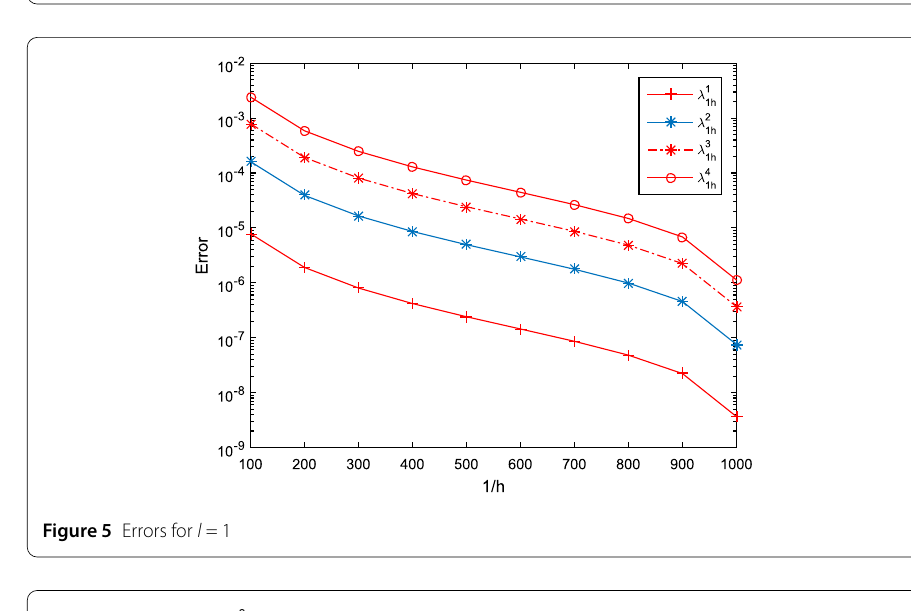
Figure 5 Errors for l = 1